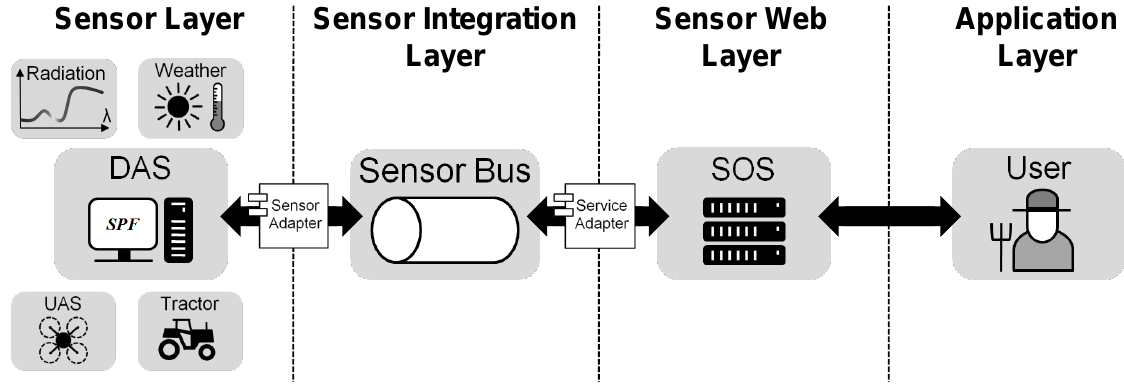
Figure 1. The extended sensor infrastructure stack as introduced by Bröring et al.